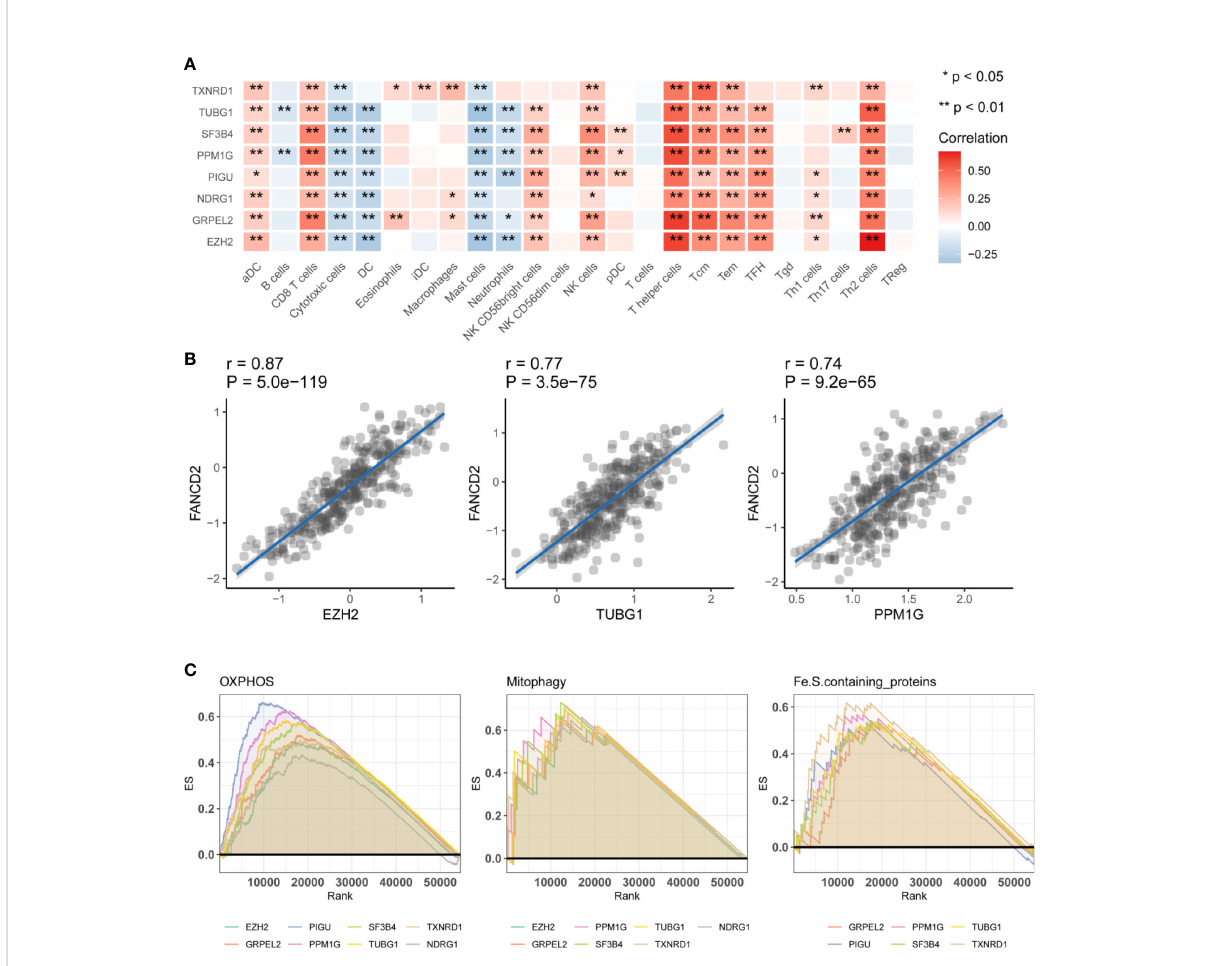
FIGURE 4 Functional analysis of the hub genes. (A) Immunoin fi ltration analysis. Gene Set Variation Analysis were used to calculate the effect of 24 types of immune cells on HCC. Signi fi cance is presented by using *p < 0.05, **p < 0.01. The darker the red color, the higher the correlation coef fi cient. (B) The correlation analysis between hub genes and ferroptosis related genes FANCD2. EZH2, TUBG1, PPM1G were signi fi cantly positive effective with FANCD2. (C) The correlation analysis of three hub genes, EZH2, GRPEL2, NDRG1, and FANCD2. Gene Set Enrichment Analysis, (GSEA) the hub genes were enriched in OXPHOS, Mitophagy, Fe.S.containing proteins. It has been partially con fi rmed that ferroptosis and mitochondrial metabolism were related to prognosis in